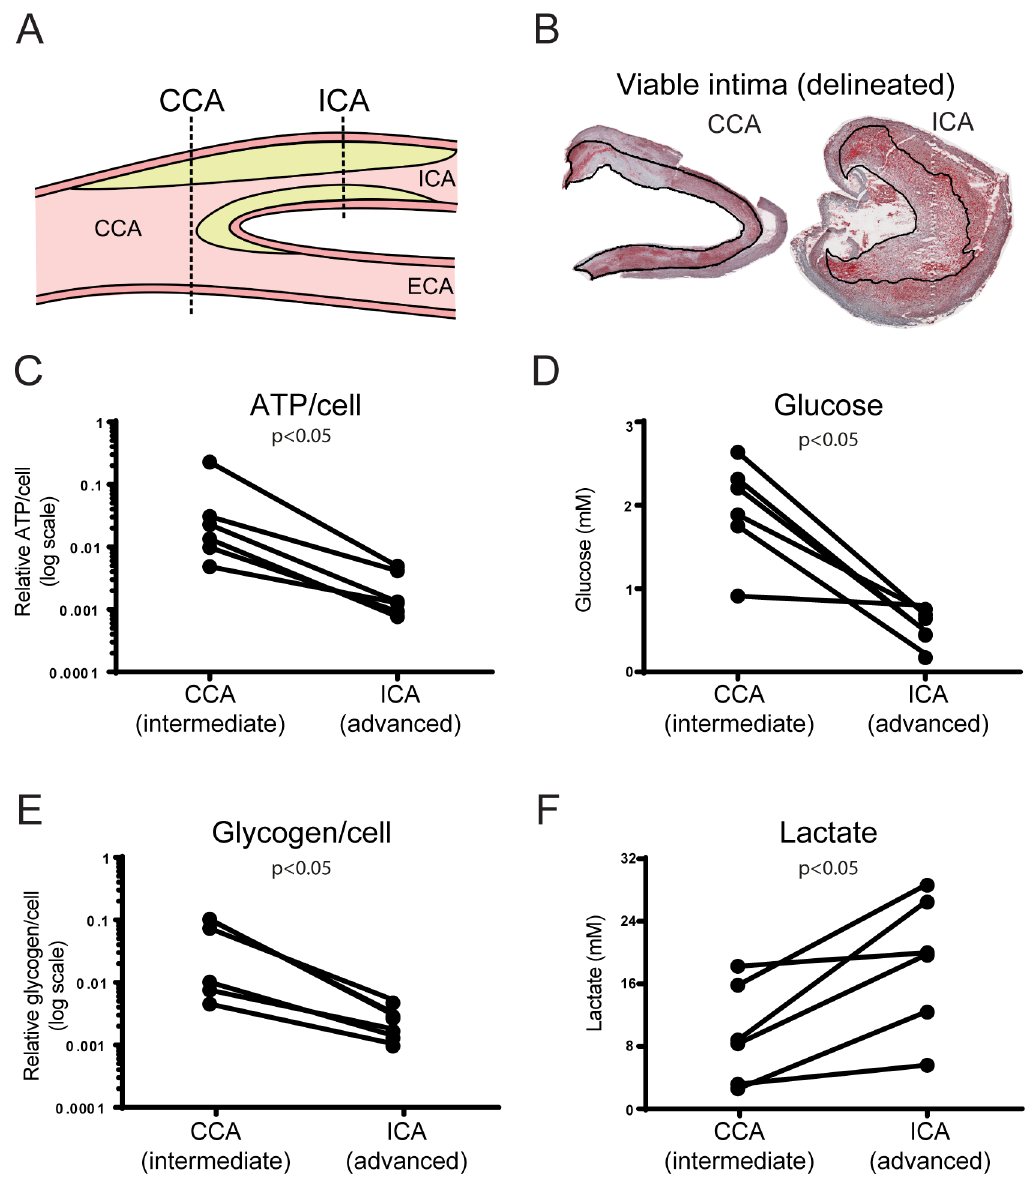
Fig 2. Depletion of ATP, glucose and glycogen in advanced human plaques. A. Energy metabolites were analyzedin intermediate (CCA) and advanced(ICA) segments of humanendarterectomies. B. Metabolite concentrations were assessedin the viable part of the intima (delineated), i.e. intimal area minus necrotic core. C, D and E. ATP (C), glucose(D) and glycogenconcentrations (E) were lower in advancedsegments than in intermediate segmentsof the same plaque.Note logarithmic scale for ATP and glycogen.F. Lactate concentrations were higherin advancedsegmentsof the plaque.n = 6, Wilcoxon Signed-Rank